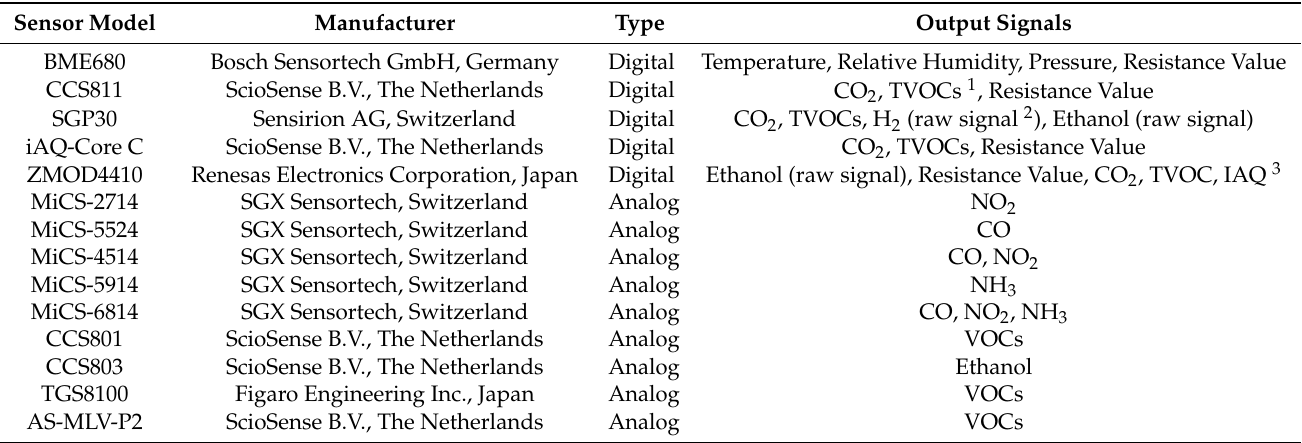
Table 1. Sensors used in multisensorNOSE and output